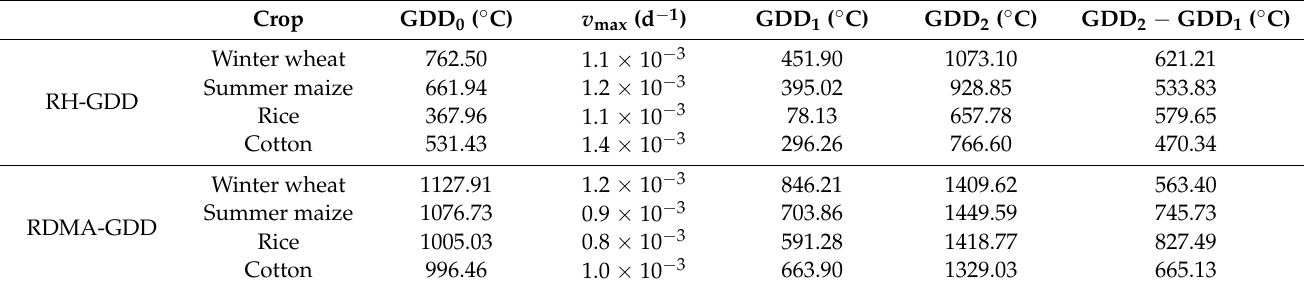
Table 11. Characteristic Values of the Semirelative Logistic Model for the Crops. GDD 0 is GDD when RH or RDMA increases the fastest. v max is the maximum rate of increase in RH or RDMA. GDD 1 is GDD when RH or RDMA increases from slow to fast. GDD 2 is GDD when RH or RDMA increases from fast to slow. GDD 2 − GDD 1 is the GDD demand for RH or RDMA during vigorous